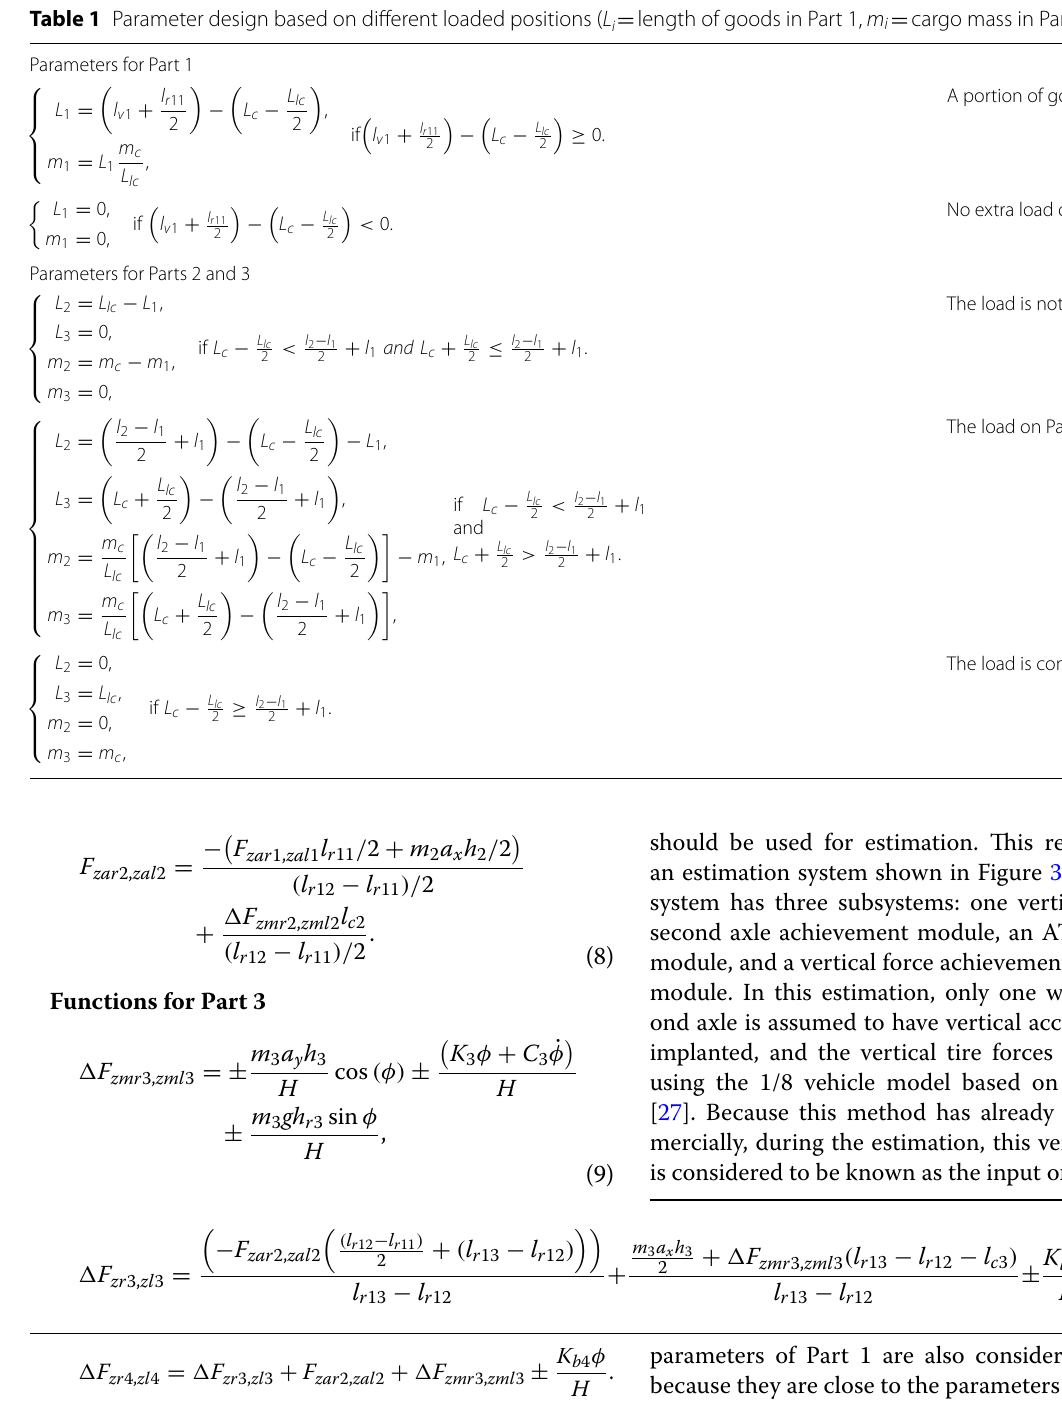
cargo mass in Part 1) =